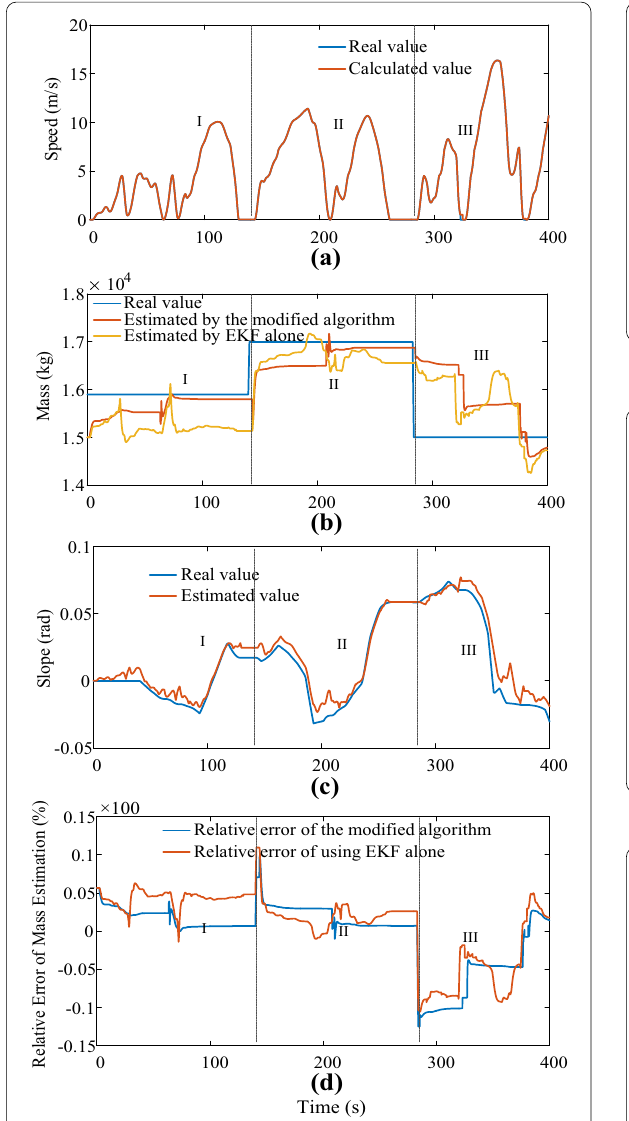
Figure 8 Results of the mass and slope estimation algorithm: ( a ) speed calculation; ( b ) whole vehicle mass estimation; ( c ) road slope estimation, and ( d ) relative error of mass estimation